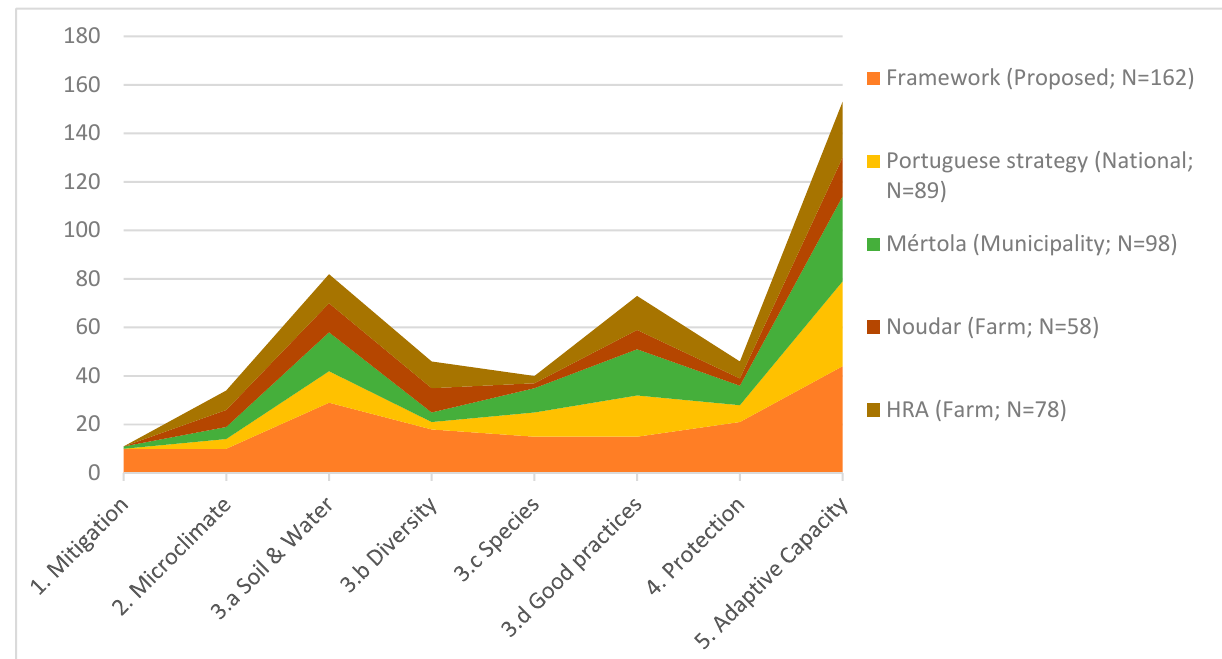
Figure 6. Number of adaptation measures (accumulated) identified in the case studies adaptation plans, in the Portuguese National Adaptation Strategy and in the proposed Framework, organized by detailed adaptation strategies.